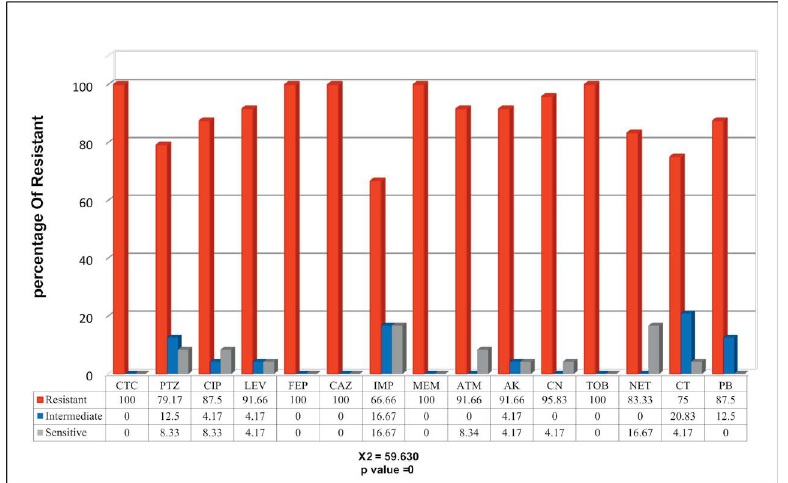
Fig. 1. The distribution of the isolates according to the sampling